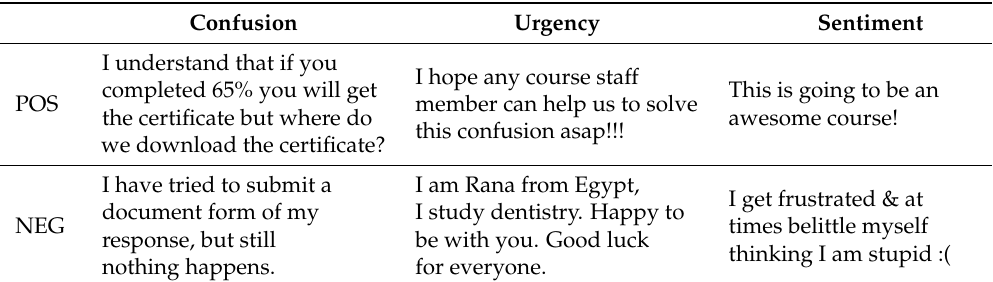
Table 1. Examples of confusion/urgency/sentiment